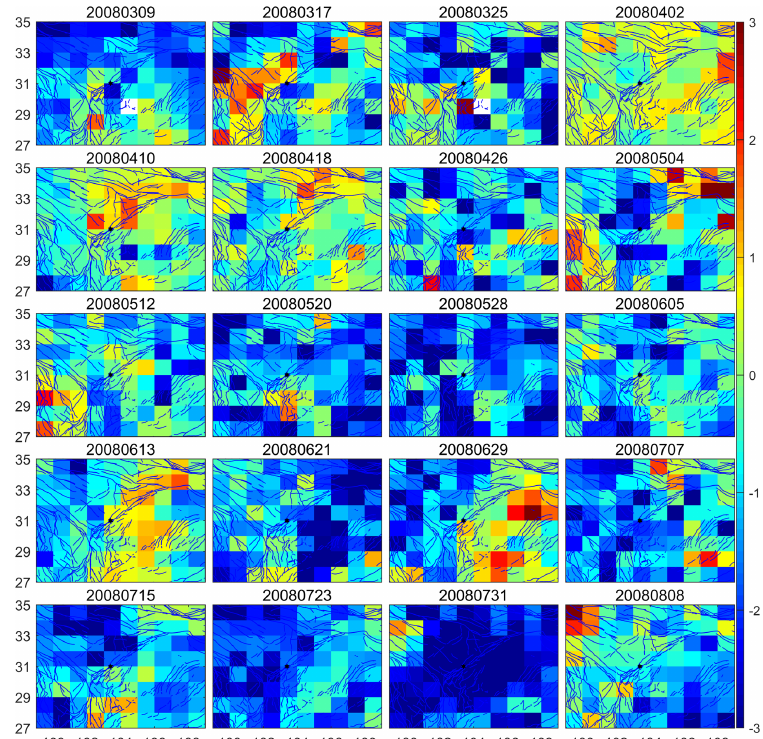
Figure 9. Gradient of 300 to